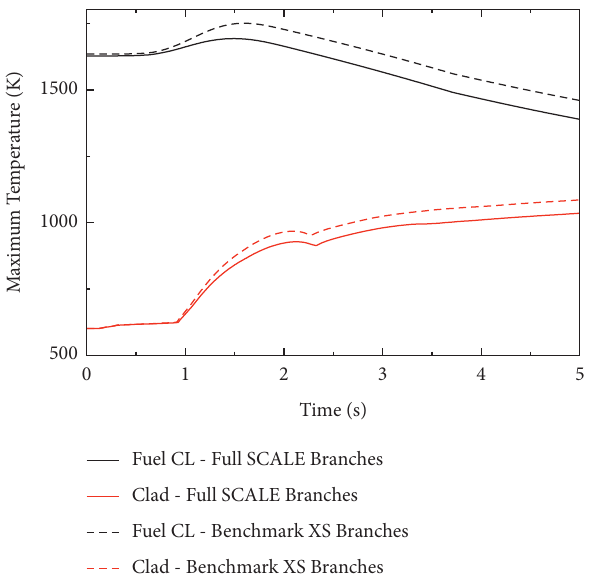
Figure 15: LOCA maximum fuel/clad temperatures.